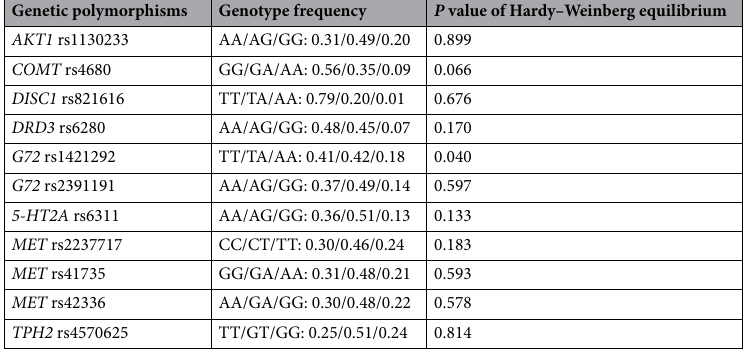
Table 1. Genotype frequencies of 11 genetic polymorphisms in 302 schizophrenia